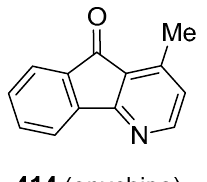
Figure 13. Structure of onychine ( 414 ).